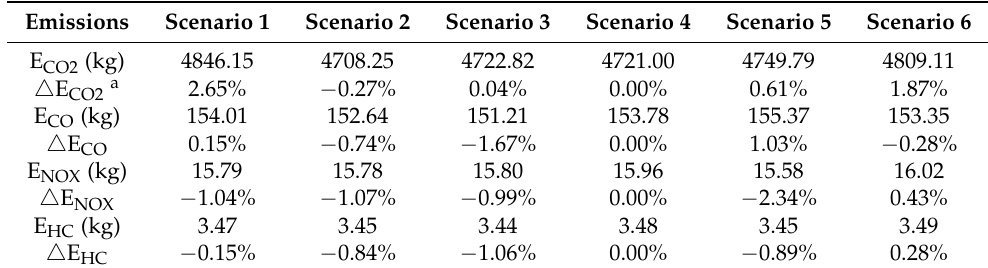
Table 8. Summary of total emissions in the simulated network and percentage differences to the base case under different